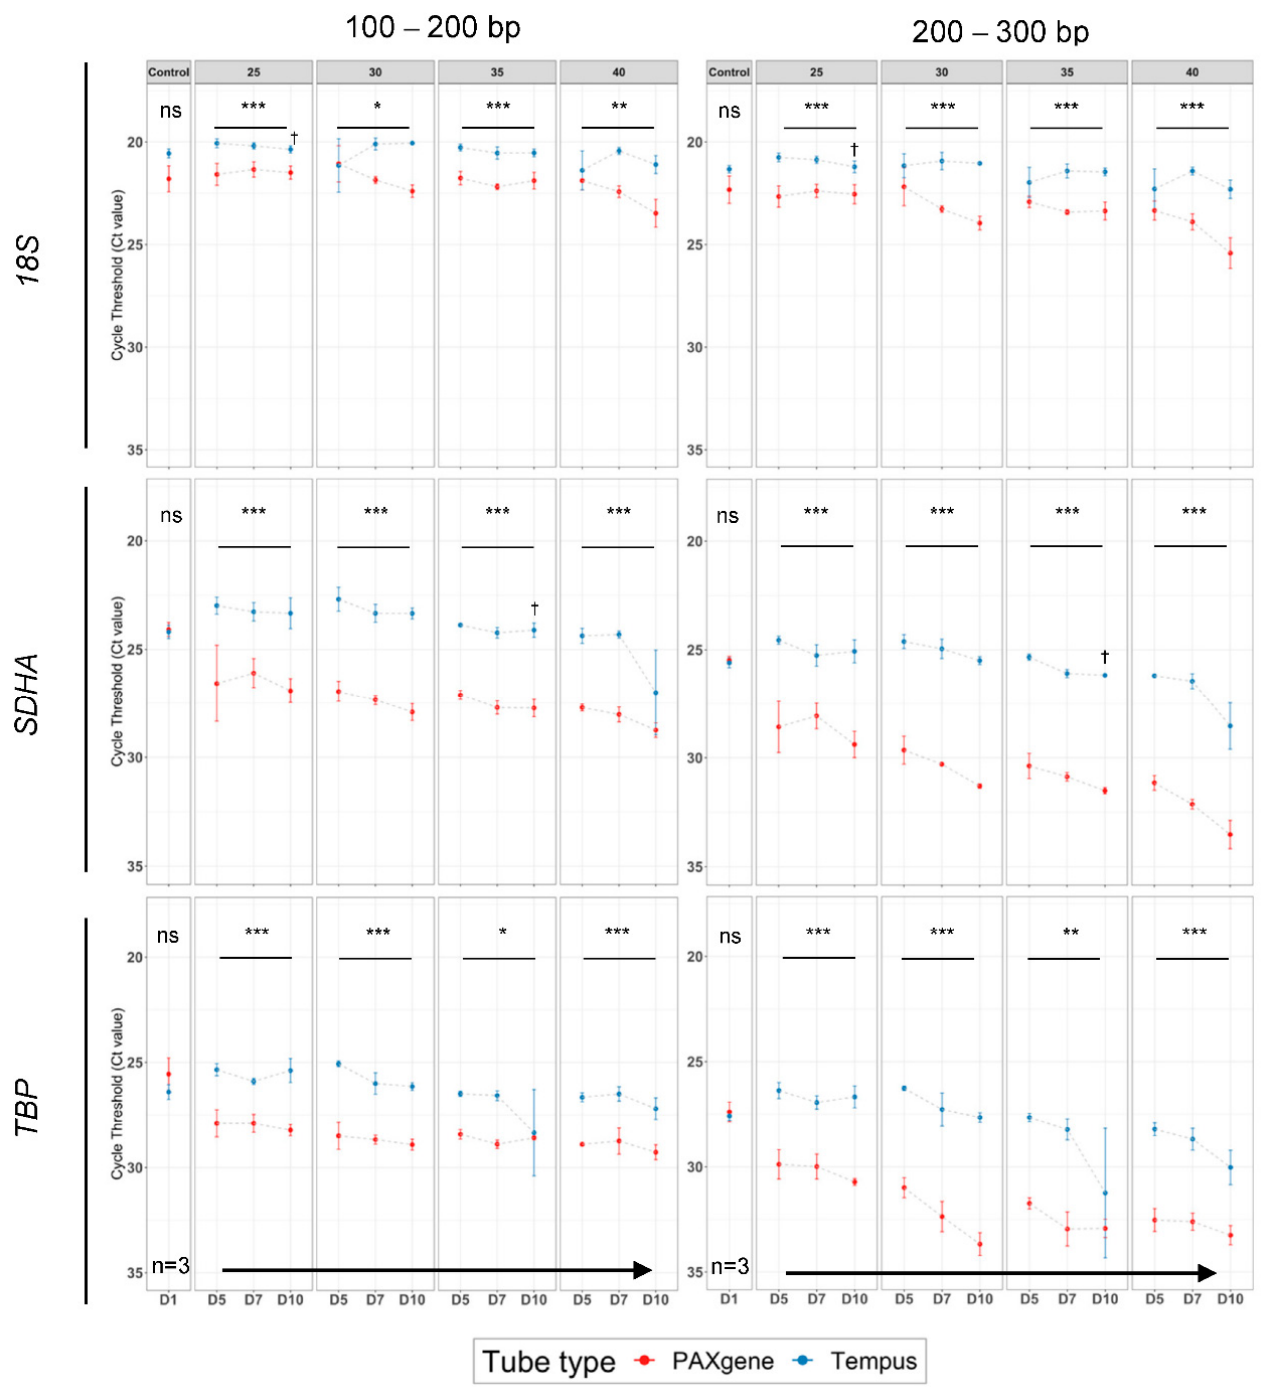
Figure 2. Cycle thresholds (Ct) of housekeeping genes assessing RNA from PAXgene ® and Tempus ™ stored at different temperatures and times. The mean cycle threshold (Ct) values for 18S , SDHA, and TBP with 100–200 base pair (bp) (short-amplicon) or 200–300 bp (medium-amplicon) lengths across different conditions (control and at multiple storage temperatures and days (matched n = 3)). *** p < 0.001, ** p < 0.01, * p < 0.05; ns, non-significant; †, data from only two observations were potentially available due to LOD. Blue, Tempus ™ Blood RNA tubes; red, PAXgene ® Blood RNA tubes.